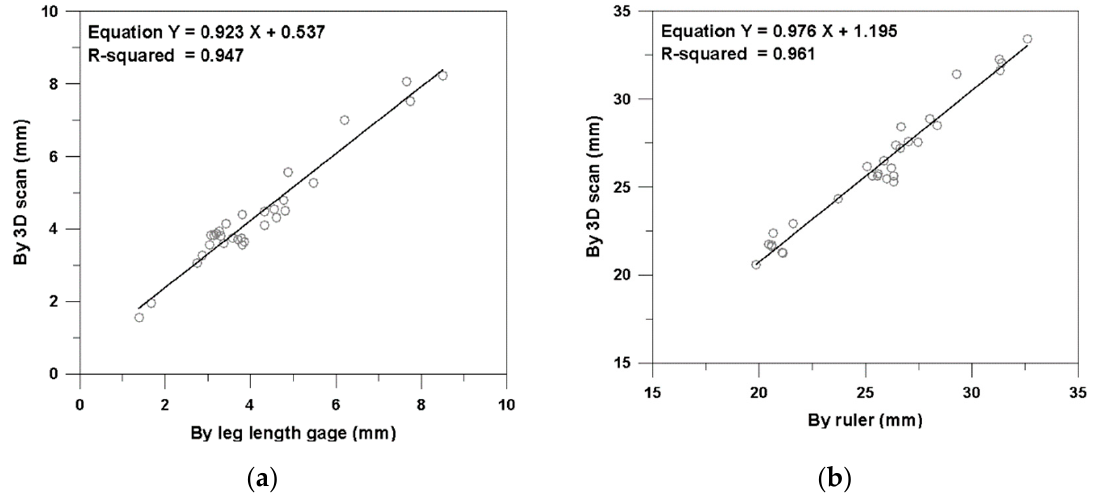
Figure 21. Correlation for each measuring method of the bead height and width: ( a ) bead height; ( b ) bead width.